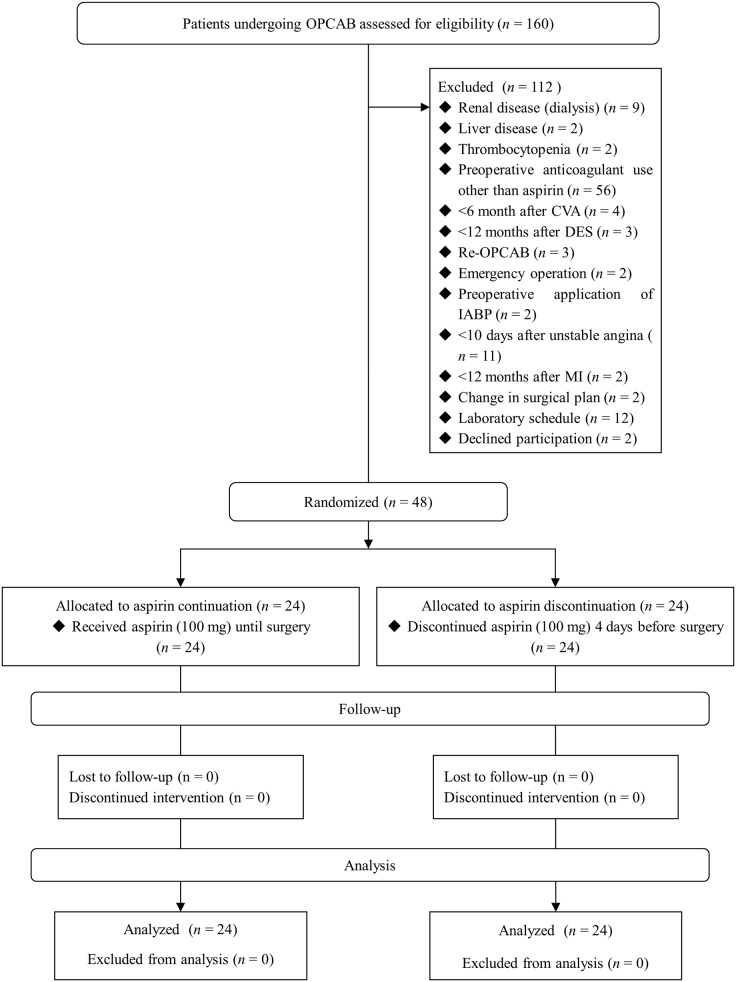
CONSORT flow diagram.